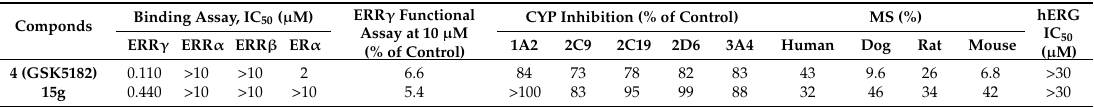
Table 2. In vitro binding and functional characterization and in vitro ADMET profile of 15g .